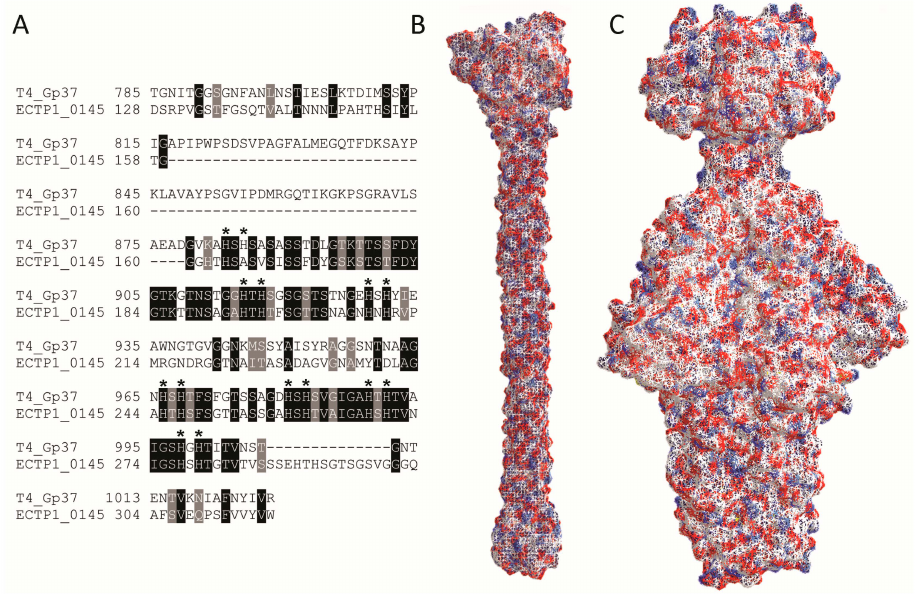
Figure 4. Alignment and structure of RBPs detected in this study. ( A ) BlastP alignment of phage T4 Gp37 receptor binding tip (amino acids 785–1026 from 1026 in the full length protein), and the corresponding homologous region of ECTP1_00145 (amino acids 128–317 from 391), showing conserved amino acids in light grey and identical amino acids in dark grey. The dashes represent gaps in the alignment. Histidines involved in iron coordination are marked with asterisks; ( B ) Protein structure of the T4 Gp37 receptor binding tip trimer (785–1026, PDB ID: 2XGF) [22]; ( C ) Protein structure of the P22 Gp9 trimer (PDB ID: 2XC1) [23]. The red and blue colours indicate negative and positive residues while the white surfaces show hydrophobic